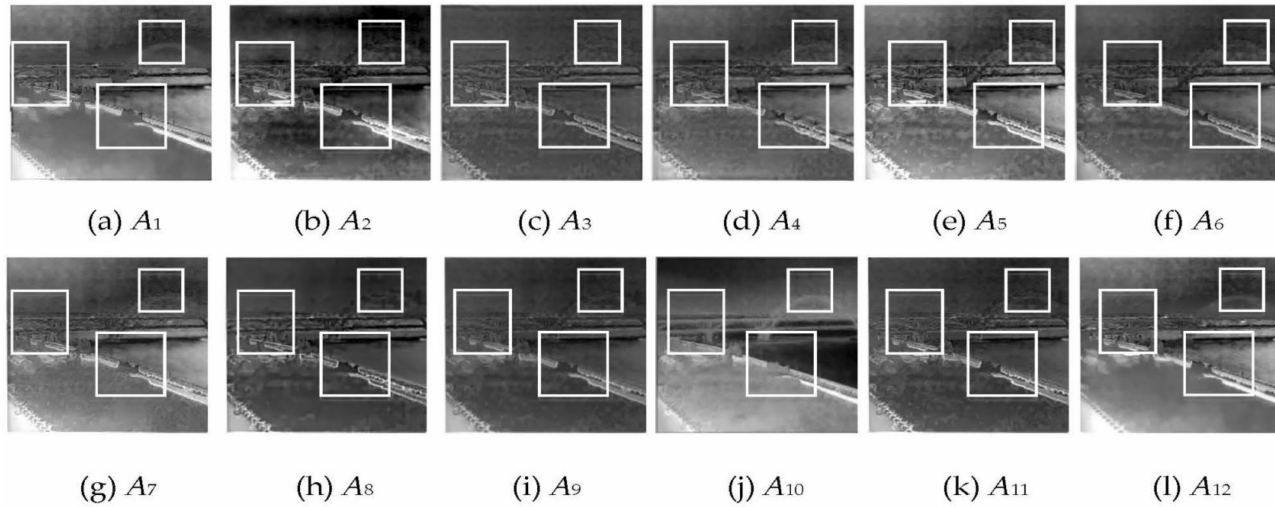
Figure 11. Fusion results of the second group of images using different